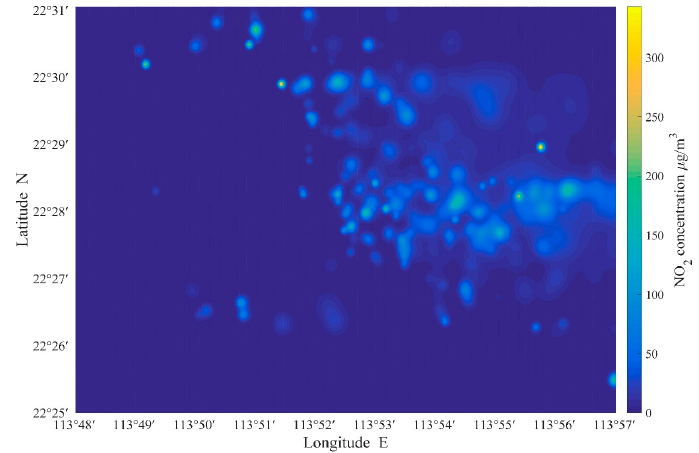
Figure 6. NO 2 concentration distribution at 1:00.